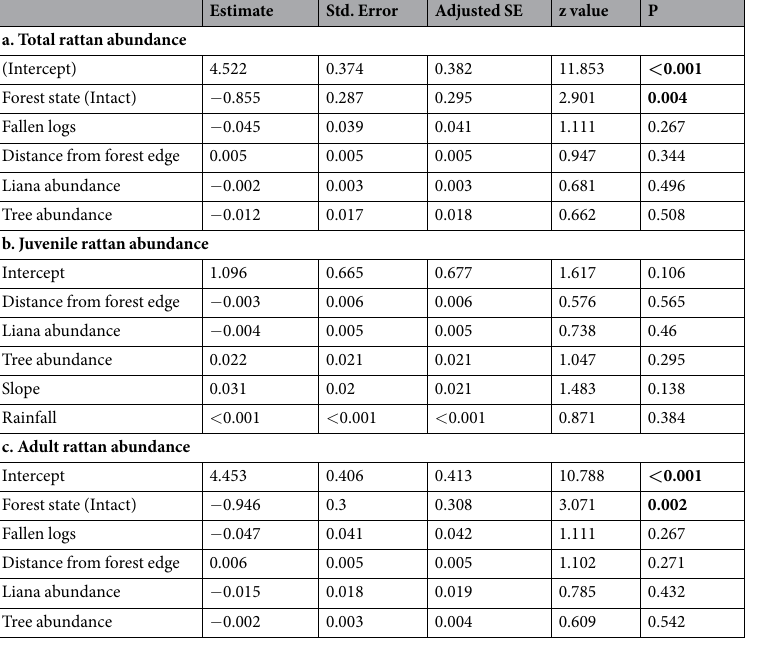
Table 2. Results of model averaged, generalized linear mixed models (negative binomial) examining forests at the landscape level (fragmented and intact forests). Response of (a) total rattan abundance, (b) juvenile rattan ( ≤ 3 m in length) abundance and (c) adult rattan ( > 3 m in length) abundance to forest fragmentation and environmental